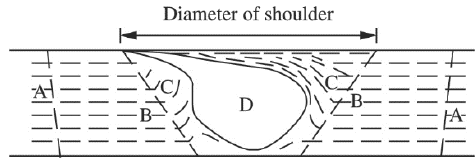
Figure 1. Schematic cross-section of a typical FSW weld showing four distinct zones: (A) base metal, (B) heat affected zone, (C) thermomechanically affected zone and (D) stirred